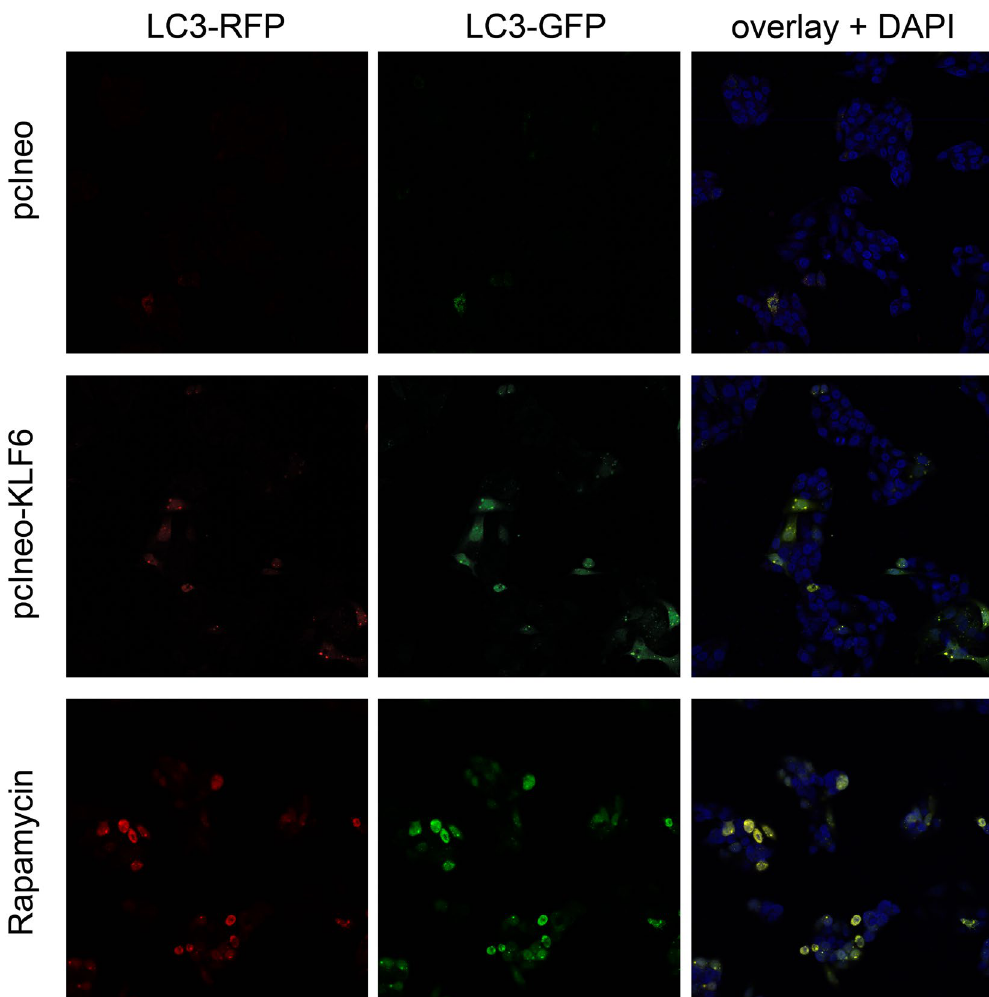
Figure 6. Autophagosome formation in KLF6 over-expressing HepG2 cells. To visualize formation of autophagosomes in HepG2 cells transfected with empty control vector (pcIneo) or in KLF6 over-expressing HepG2 cells (pcIneoKLF6) we treated the cells with Autophagy Tandem Sensor RFP-GFP-LC3B. As a positive control, we stimulated autophagosome formation via treatment with 15 µ M rapamycin for 6 h. Cells were viewed and imaged with a Leica SP8 confocal microscope (20-fold magnification); shown are representative images of n = 3 individual cell culture